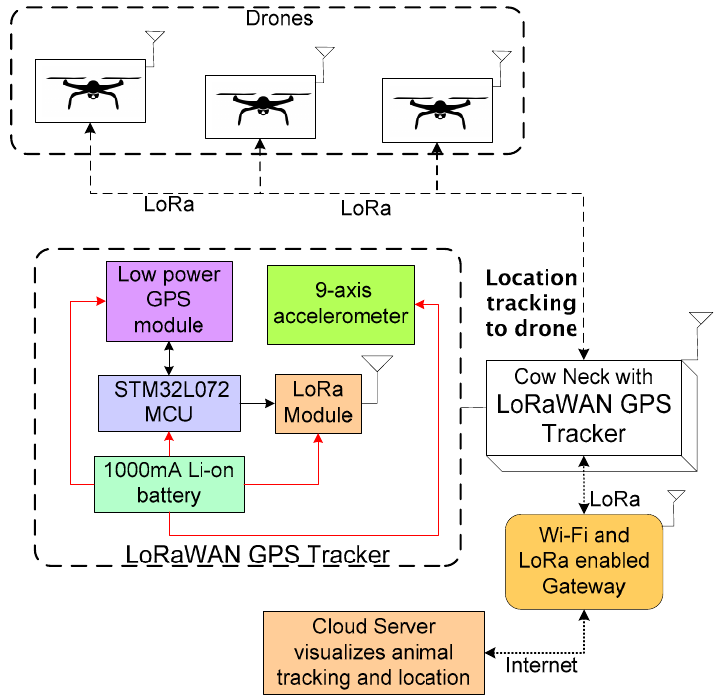
Figure 5. LoRa based Architecture of animal location tracking and identification.